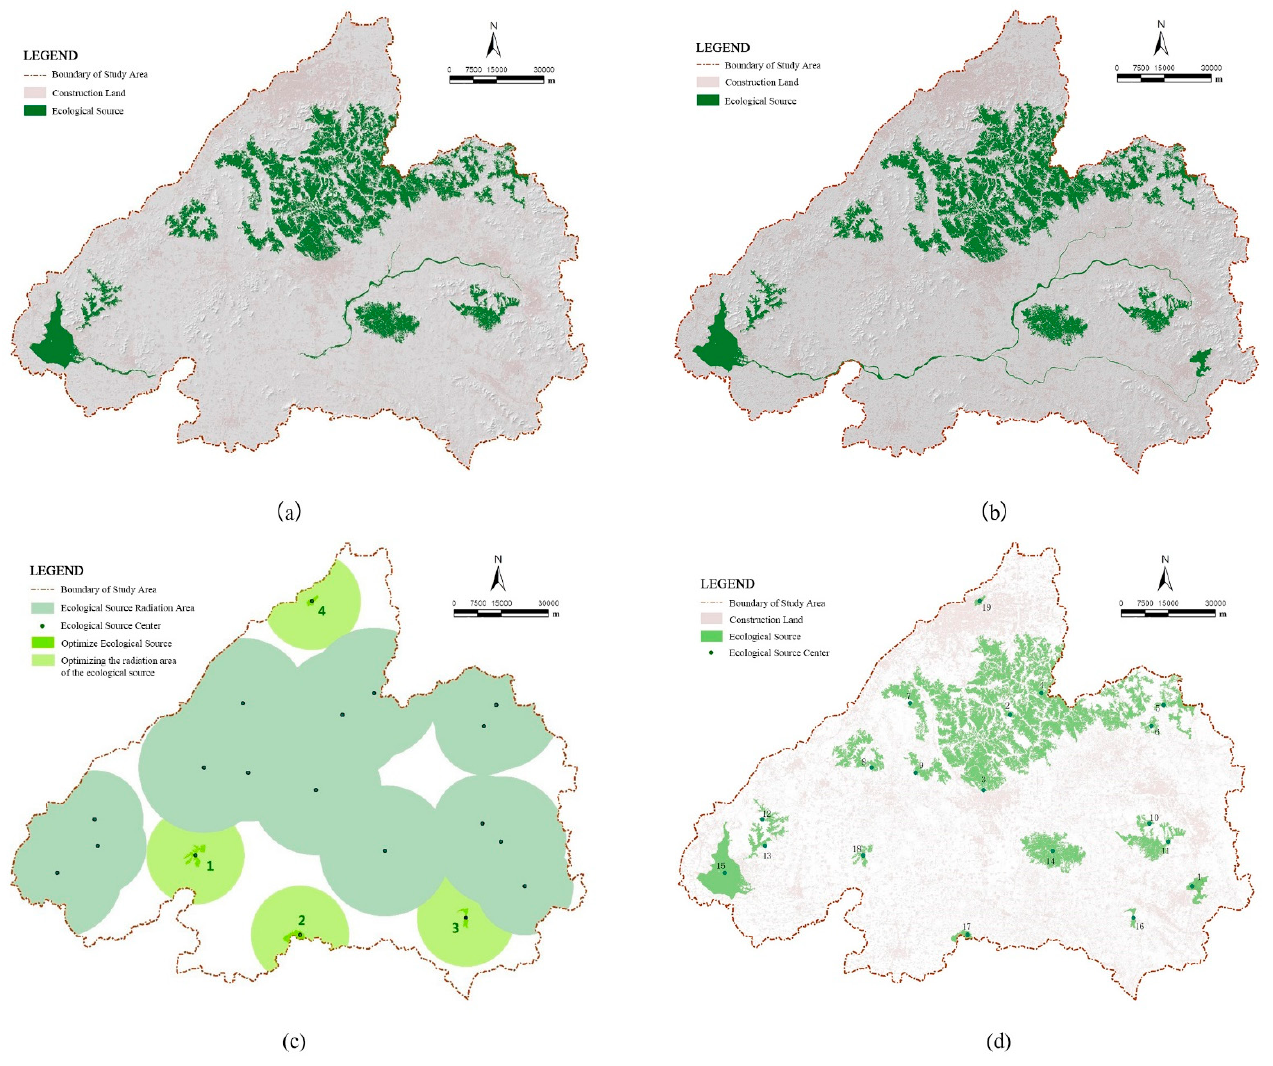
Figure 8. Ecological sources in Taishan area: ( a ) Identification of ecological sources in Taishan area based on MSPA analysis; ( b ) Comprehensive ecological source of Taishan area; ( c ) Service scope of ecological source area of Taishan area; ( d ) Optimization of ecological source area of life community of mountains–rivers–forests–farmlands–lakes–grasslands in Taishan area.